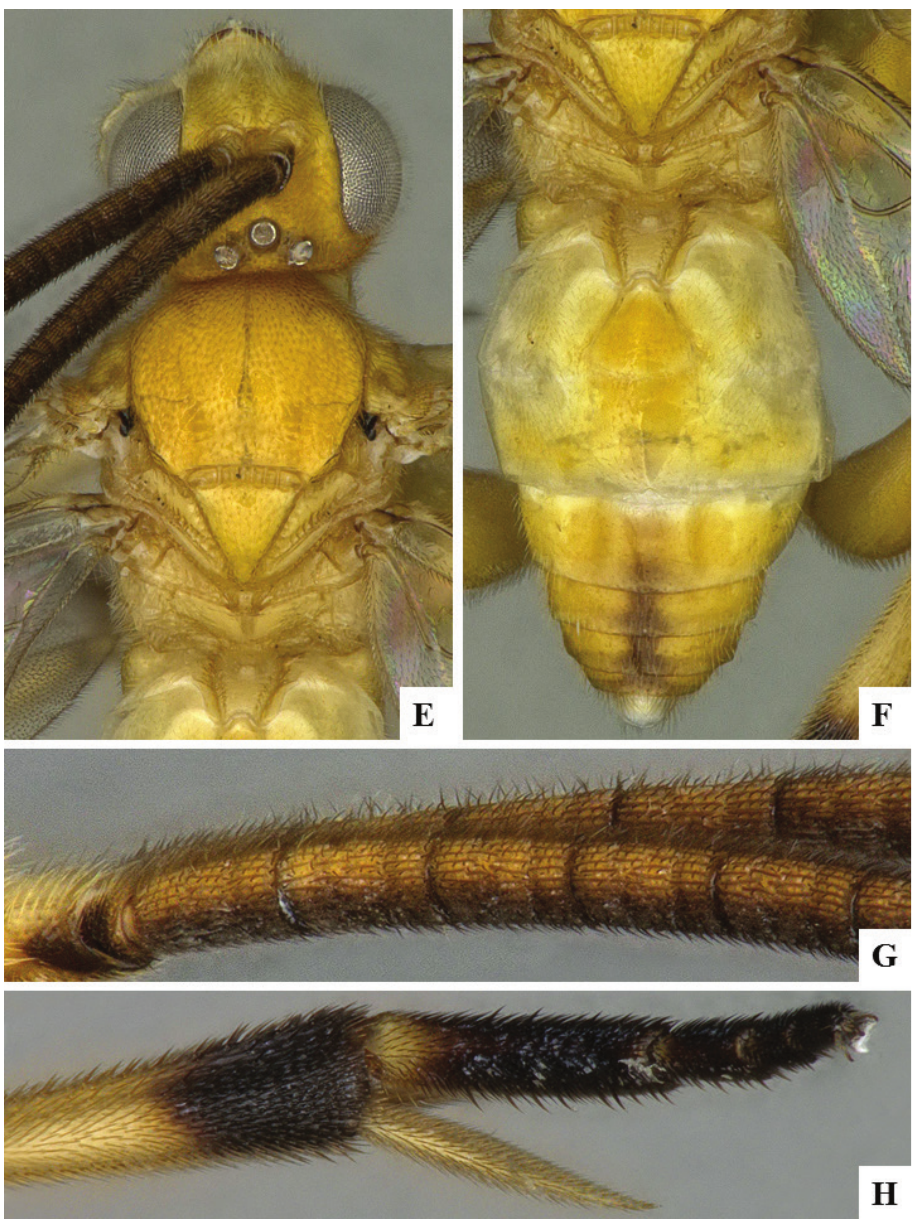
Figure 25. Jimwhitfieldius jamesi female paratype CNC878555. E Head and mesosoma, dorsal F Metasoma dorsal G Antennal flagellomeres 1 to 5 H Inner spine of metatibia. veins dark brown. Body mostly smooth, with very shallow and sparse punctures in some areas. Flagellomeres with placodes arranged in three rows. Head posteriorly with a deep depression, behind occiput. Hypostomal carina with projecting flange. Mesosoma